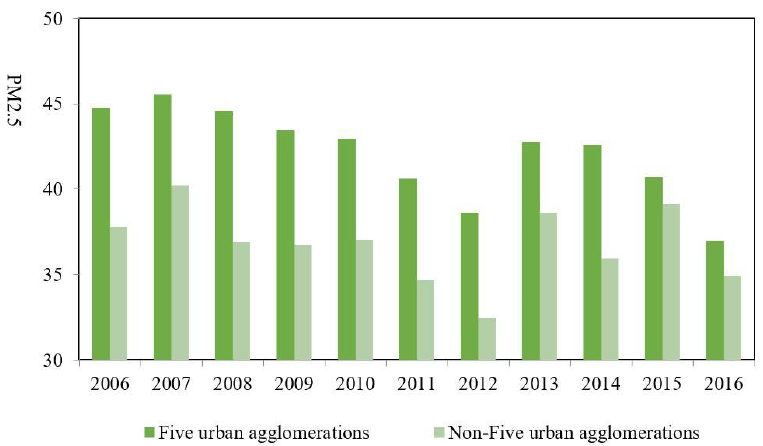
Figure 3. Changes in PM2.5 of five major urban agglomerations and non-five major urban agglomerations.